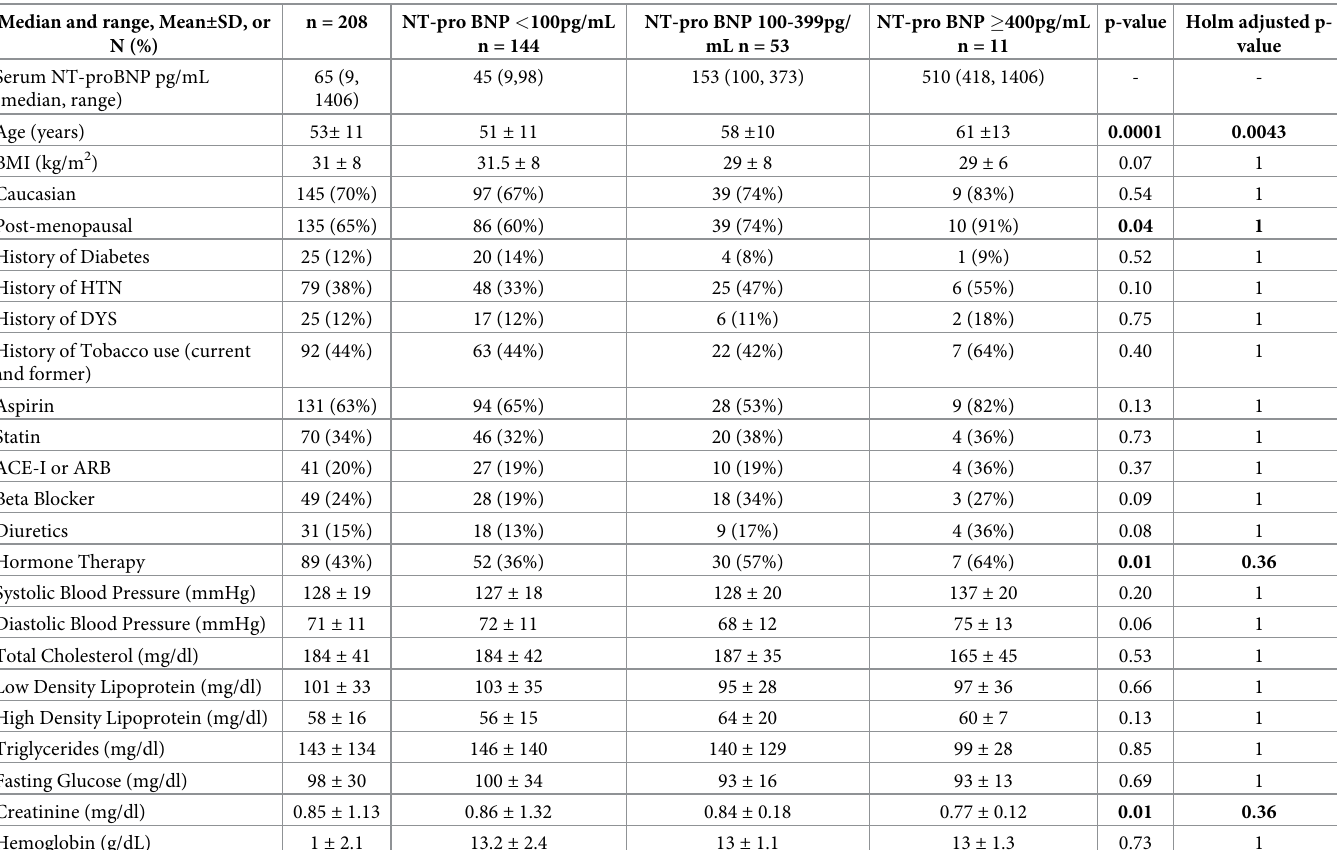
Table 1. Baseline